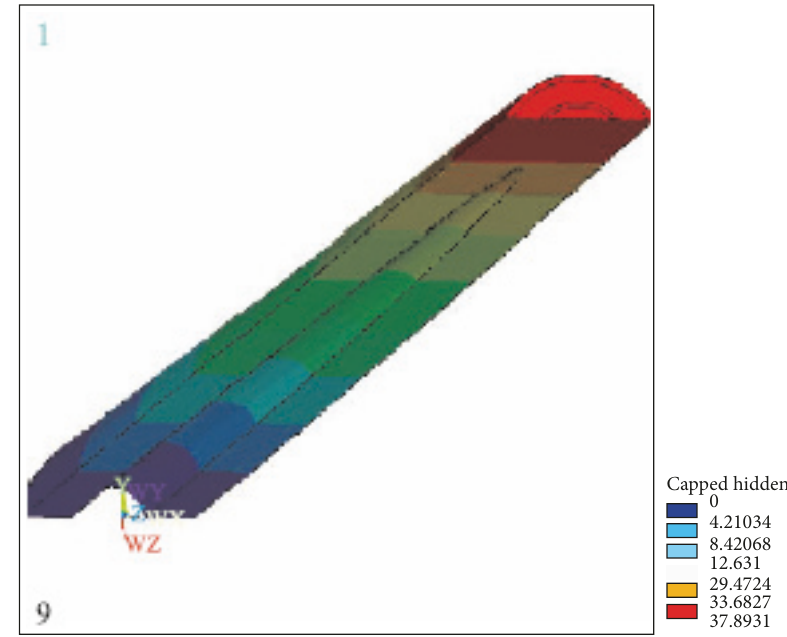
Figure 5: Axial casing elongation in the air and seawater section (0 ∼